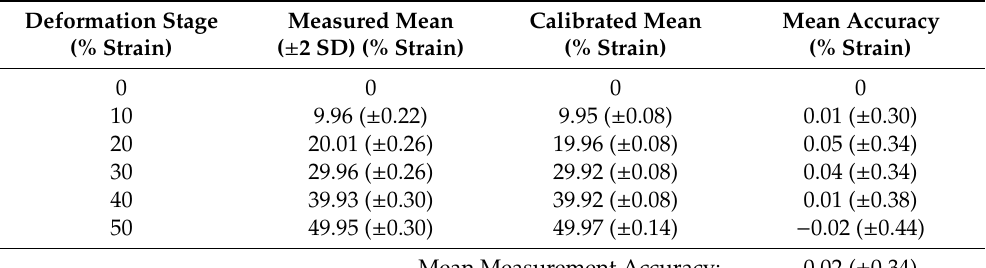
Table 5. Measurement accuracy results for each deformation stage at a 95% confidence level for measured deformations and incorporating edge detection error for calibrated deformations.